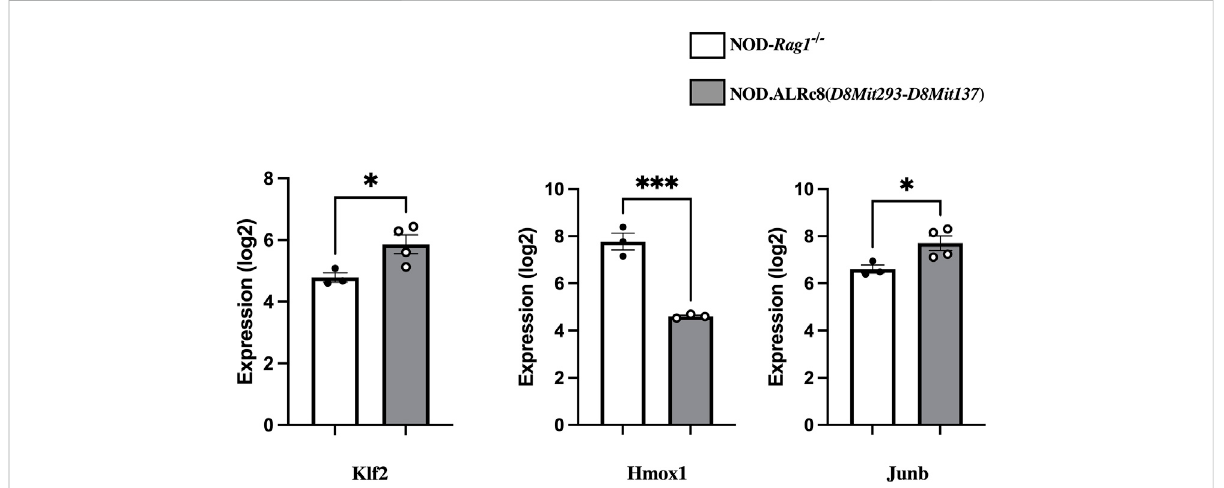
FIGURE 8 Transcriptomeanalysisidenti fi edgenesdifferentiallyexpressedinisletsfrominsulitis-freeNOD- Rag1 − / − andNOD.ALRc8( D8Mit293 - D8Mit137 ) mice. Shown here are the expression of Klf2 , Hmox1 and Junb in islets from NOD- Rag1 − / − (open bars, n = 3 pools) and NOD. ALRc8 ( D8Mit293 - D8Mit137 ) (Grey bars, n = 4 pools), respectively compared using an unpaired t test. * p < 0.05. *** p <